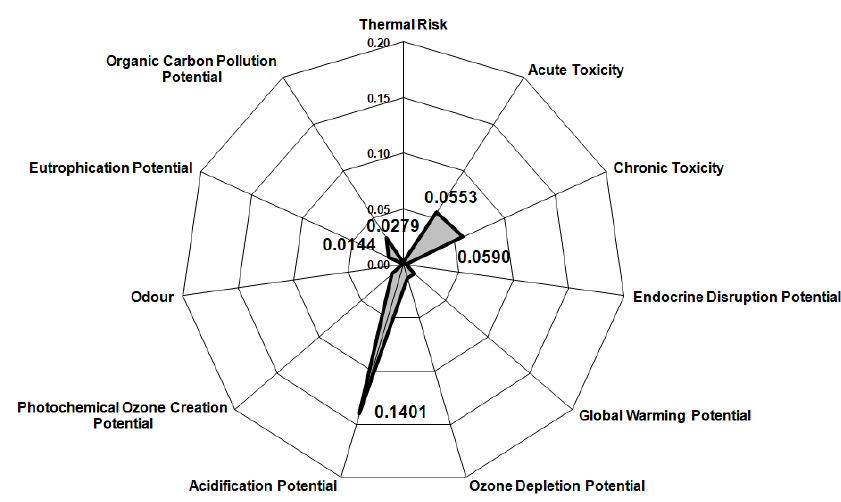
Figure 5. Environmental impact assessment for output streams.